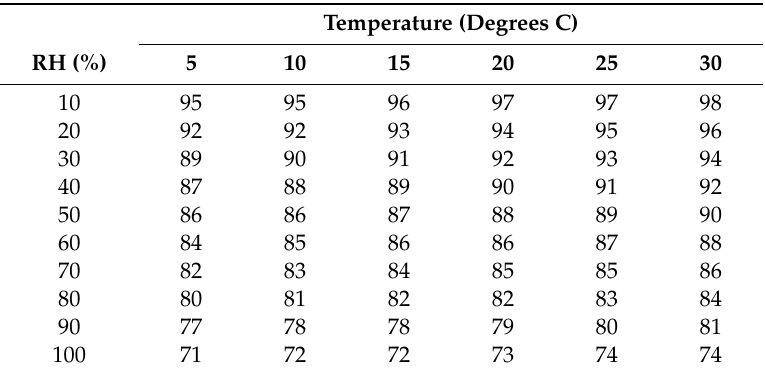
Table A7. Modified FFMC value for the NS-1 shrubland fuel complex. The method uses the Equilibrium Moisture Content model from the FWI System to estimate moisture content using temperature and relative humidity